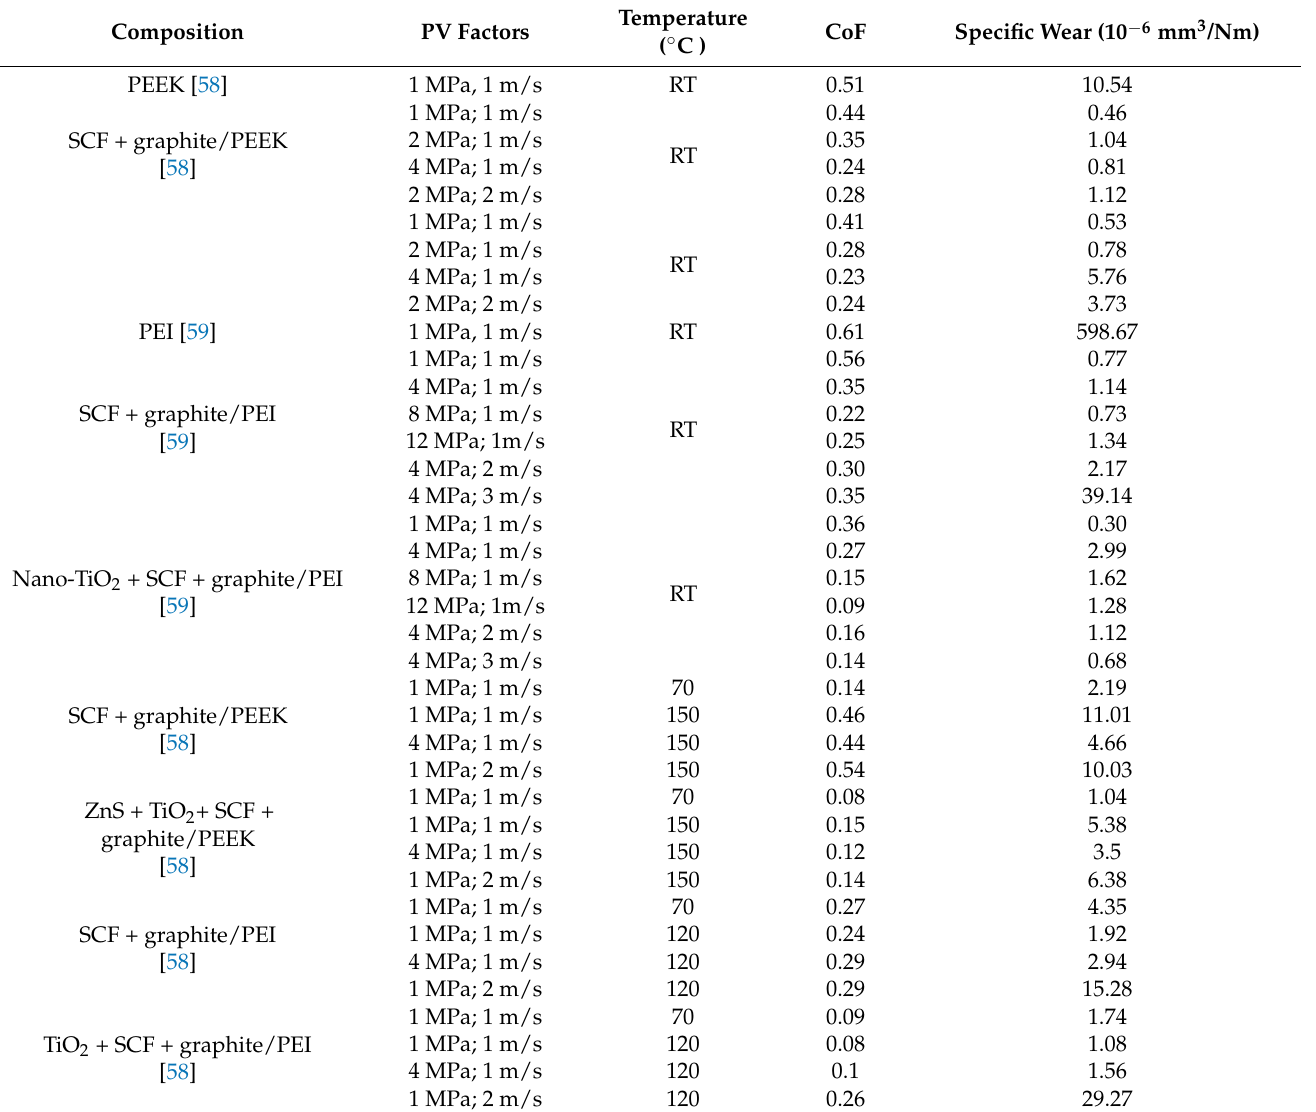
Table 4. Tribological properties of polymer composites under different PV